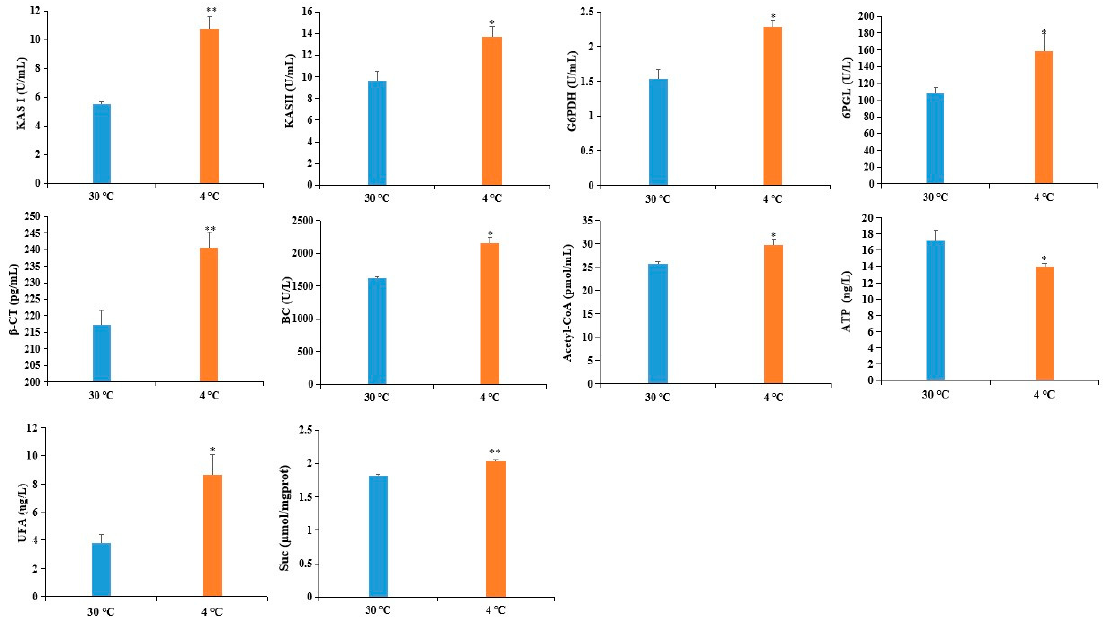
Figure 4. Validation of DAPS by ELISA. Values represent the means ± SD from three fully independent biological replicates. * p < 0.05, ** p < 0.01 by Student ’ s t ‐ test.